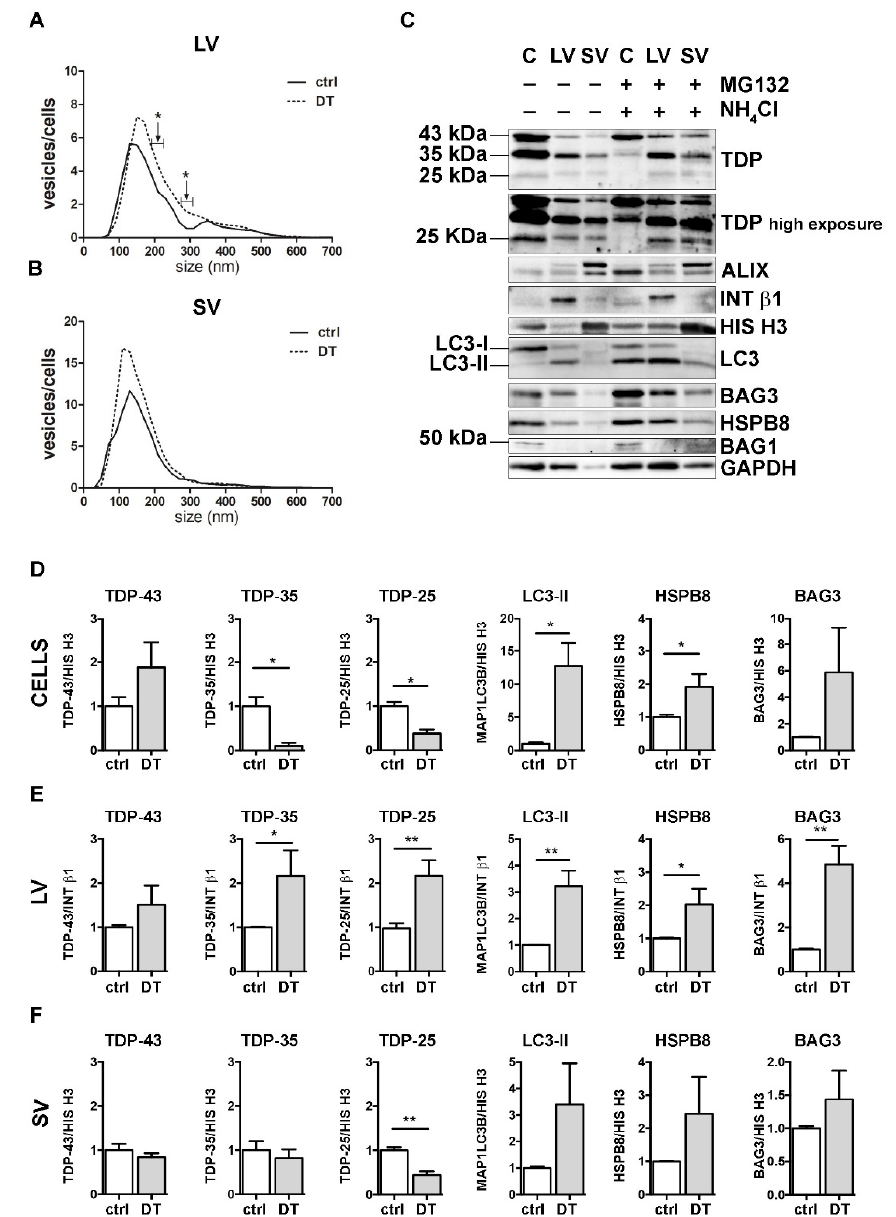
Figure 5. A complete PQC system blockage boosted the extracellular secretion of C-terminal TDP-43 fragments. ( A , B ) NTA distribution of LVs ( A ) and SVs ( B ) isolated from NSC-34 cells treated o/n with both MG132 (10 µ M) and NH 4 Cl (20 mM) (DT = double-treated samples). Graphs represent the mean of n = 3 biological replicates; x -axis = vesicles dimension, expressed in nm; y -axis = vesicles concentration, expressed as ratio between the number of vesicles and the number of secreting cells. Data show that PQC blockage statistically increased the secretion of 190–230 and 270–310 nm large vesicles ( A ) (* p < 0.05, Welch’s t -test). ( C – F ) WB analysis ( C ) and relative quantifications ( D – F ) of total RIPA-extracted proteins from NSC-34 cells, LVs and SVs, untreated or treated o/n with MG132 (10 µ M) and NH 4 Cl (20 mM). Samples were analyzed for TDP-43 species, MAP1LC3B-II, BAG3, HSPB8, BAG1, ALIX, INT β 1 and HIS H3. Bar graphs represent the mean optical density ± SD of a specific protein normalized on the optical density of the internal housekeeping protein (HIS H3 for cells and SVs; INT β 1 for LVs) and reported in comparison to the corresponding untreated sample (ctrl), for three biological replicates. (* p < 0.05, ** p < 0.01, unpaired one-tailed t -test).